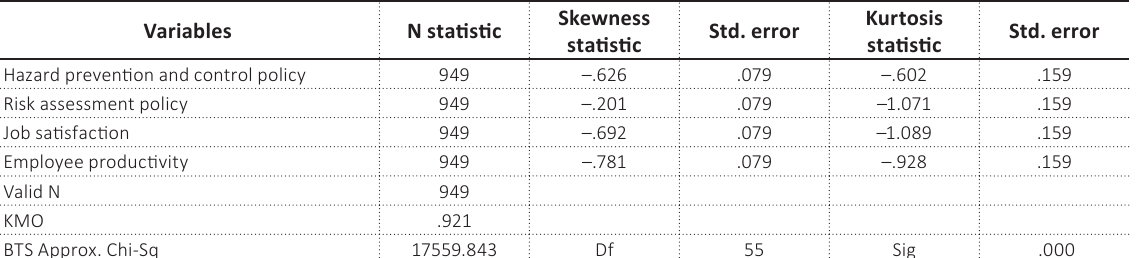
Table 2. Summary of normality test results